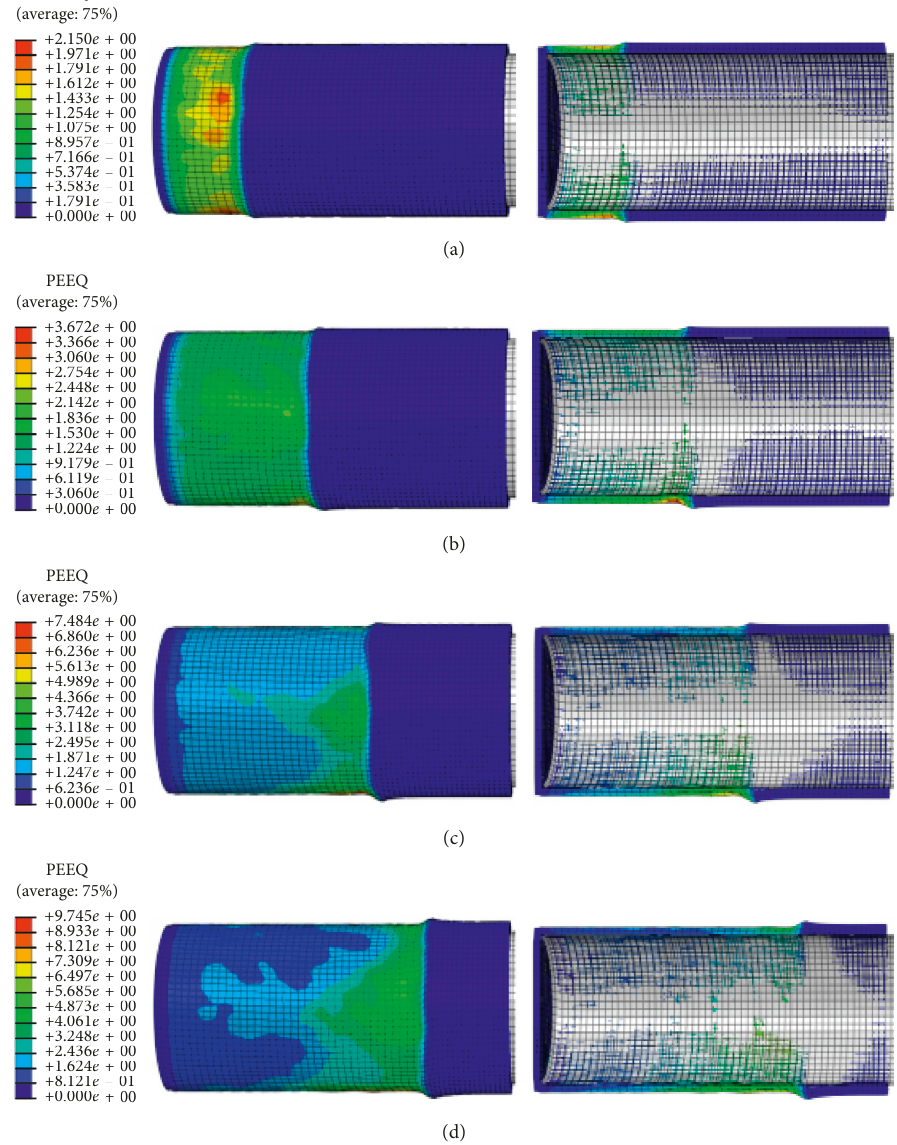
Figure 14: Fourth-pass equivalent strain distribution. (a) 25%. (b) 50%. (c) 75%. (d)